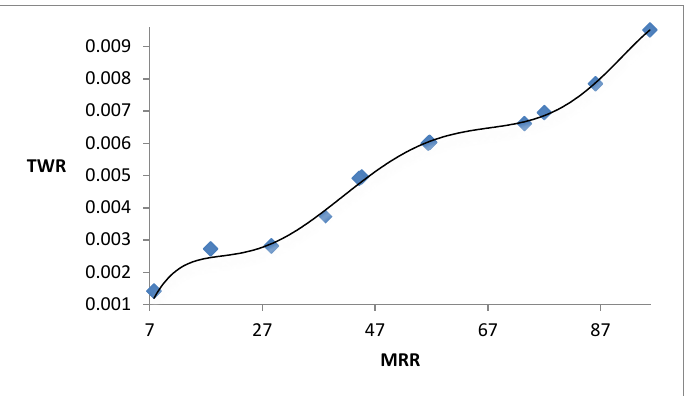
Figure 16. Pareto front between MRR and TWR.